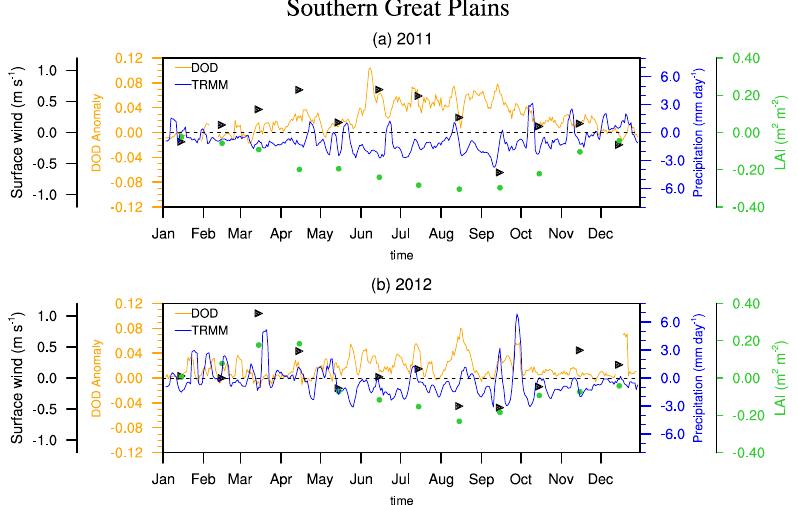
Figure 4. Case studies of two dry years in the southern Great Plains. Daily MODIS Aqua DOD and TRMM precipitation anomalies (with reference to the mean of 2003–2015) are plotted in orange and blue lines, respectively, while monthly anomalies of NARR surface wind and the bareness calculated from AVHRR LAI are plotted in black triangles and green dots, respectively. Five-day running mean is applied to daily precipitation and DOD time